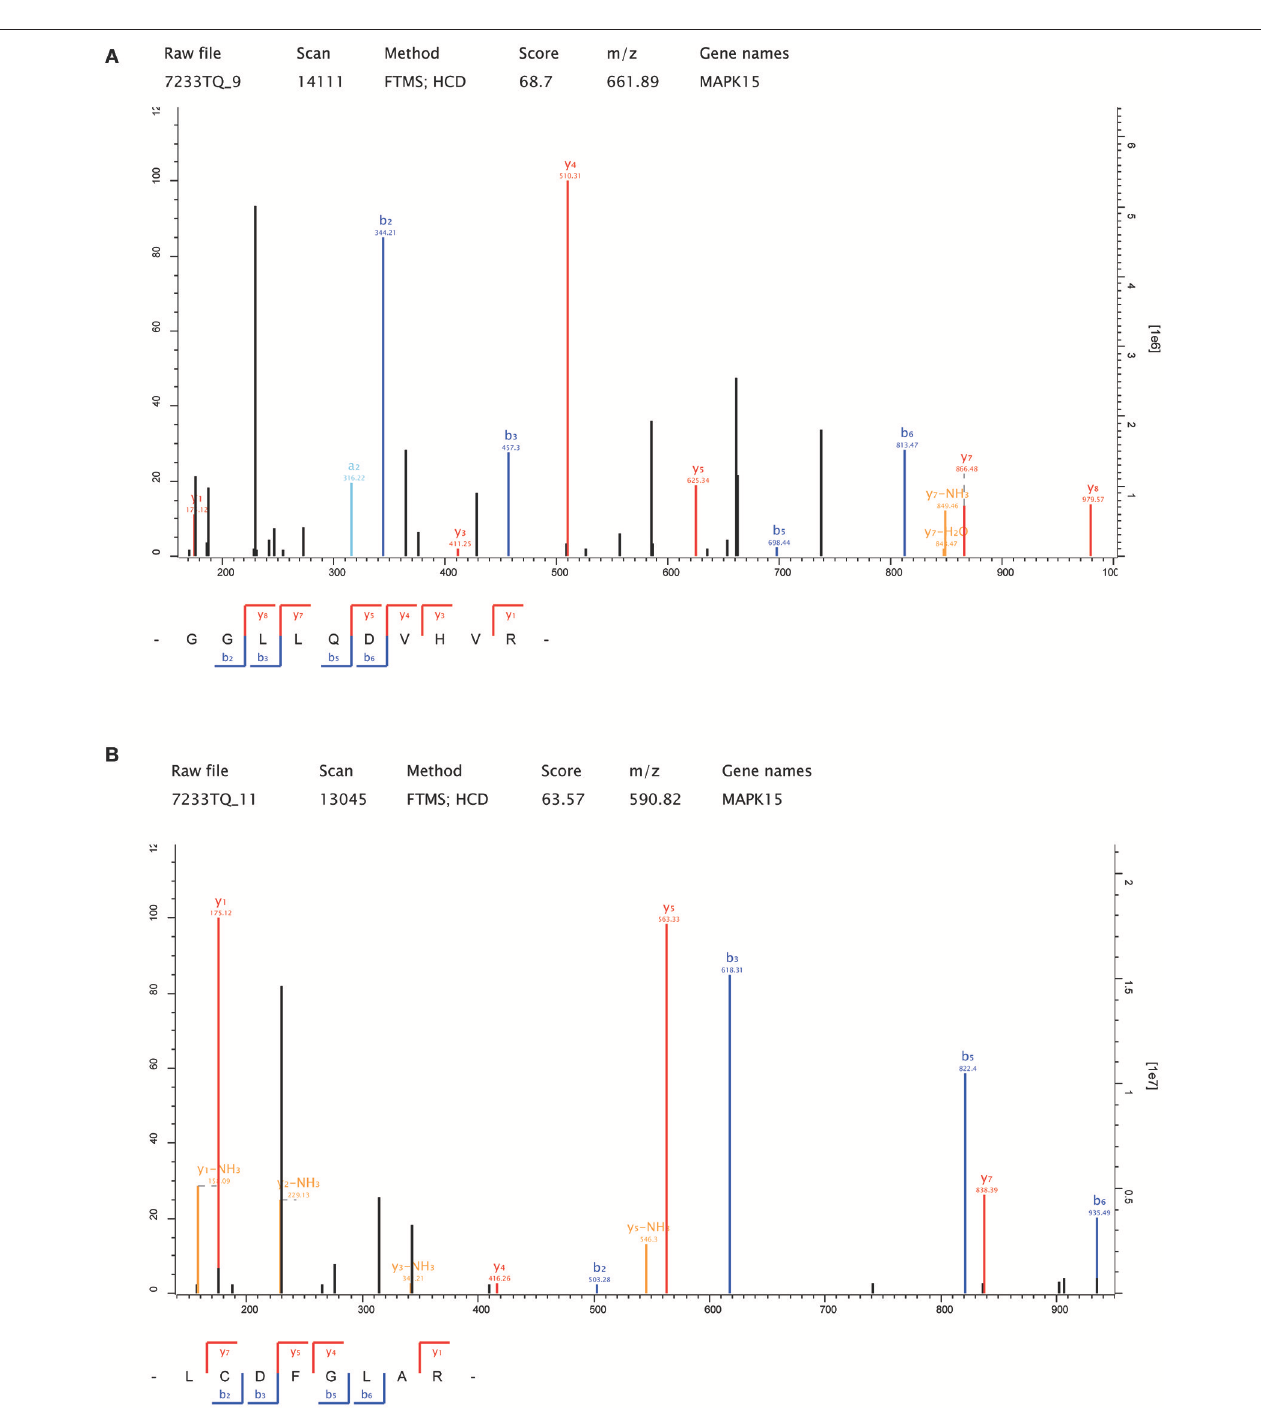
FIGURE 4 | The amino acid sequences of the two unique MAPK15 peptides identified by LC-MS/MS. (A) GGLLQDVHVR; (B) LCDFGLAR.